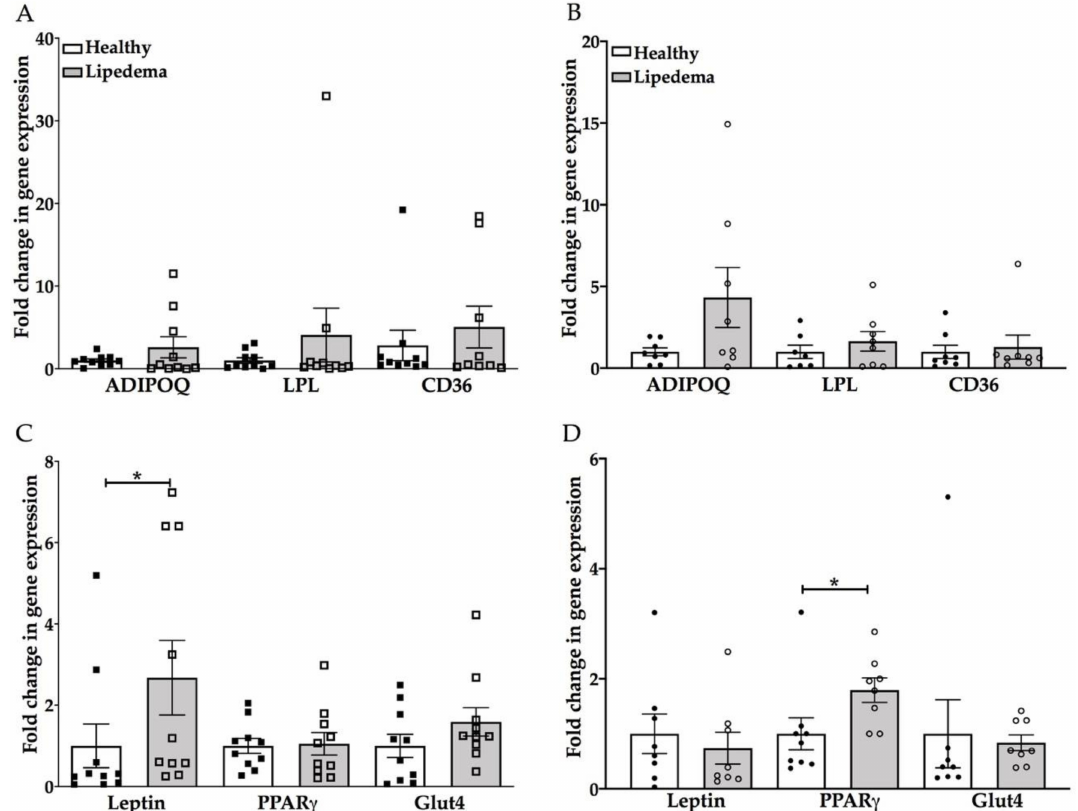
Figure 3. The adipogenic di ff erentiation marker genes increased in di ff erentiated adipocytes of lipedema ( A , C ) ASCs-T and ( B , D ) ASCs-A as compared to corresponding cells from healthy ASCs. ( A , B ) The qRT-PCR analysis showed a trend of increase in adiponectin, LPL and CD36 gene expression in di ff erentiated adipocytes of lipedema ASCs-T and ASCs-A as compared to healthy di ff erentiated adipocytes (ASCs-T: n = 10 per group; ASCs-A: n = 8 per group). ( C , D ) The qRT-PCR analysis showed ( C ) a significant increase in leptin gene expression in di ff erentiated adipocytes of lipedema ASCs-T and ( D ) a significant increase in PPAR- γ gene expression in di ff erentiated adipocytes of lipedema ASCs-A, with no change in the Glut4 gene expression as compared to healthy di ff erentiated adipocytes (ASCs-T: n = 10 per group; ASCs-A: n = 8 per group). The gene expression of di ff erentiated adipocytes are calculated from the percent of undi ff erentiated, control cells. The results are displayed as scatter plots with bars. The values are the mean ± SEM. * p < 0.05. Abbreviations: ADIPOQ: adiponectin; LPL: Lipoprotein lipase; PPRA- γ : peroxisome proliferator-activated receptor gamma; and CD36: cluster of di ff erentiation